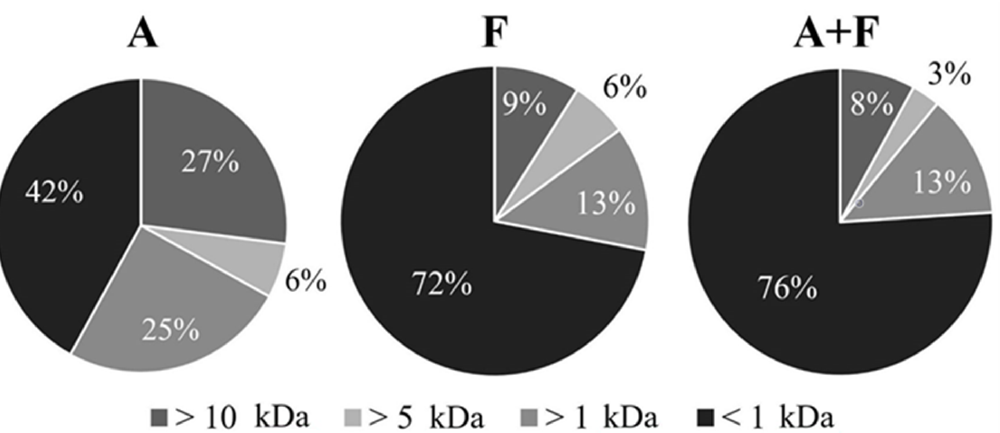
Figure 2. Yields ( w / w ,%) after sequential ultrafiltration of hydrolysates A, F, and A + F through MWCO membranes of 10, 5 and 1 kDa.